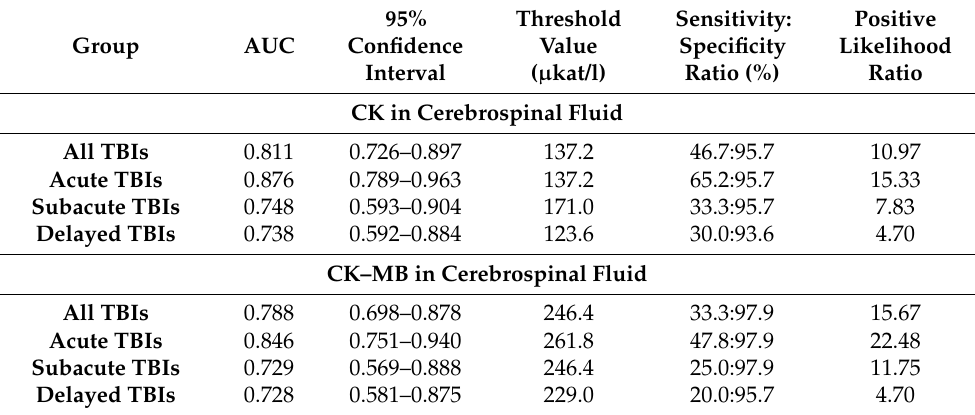
Figure 4. Receiver operating characteristics (ROC) curves are shown for ( A ) creatine kinase (CK) and ( B ) heart-type creatine kinase (CK–MB). Descriptive data to the ROC curves is depicted in Table 2. TBI, traumatic brain injury. Table 2. Descriptive data to the receiver operator characteristics curves in Figure 4 and results of the specificity-accentu- ated threshold value analysis. AUC, area under the curve; CK, creatine kinase; CK–MB, heart-type creatine kinase; TBI, traumatic brain injury.